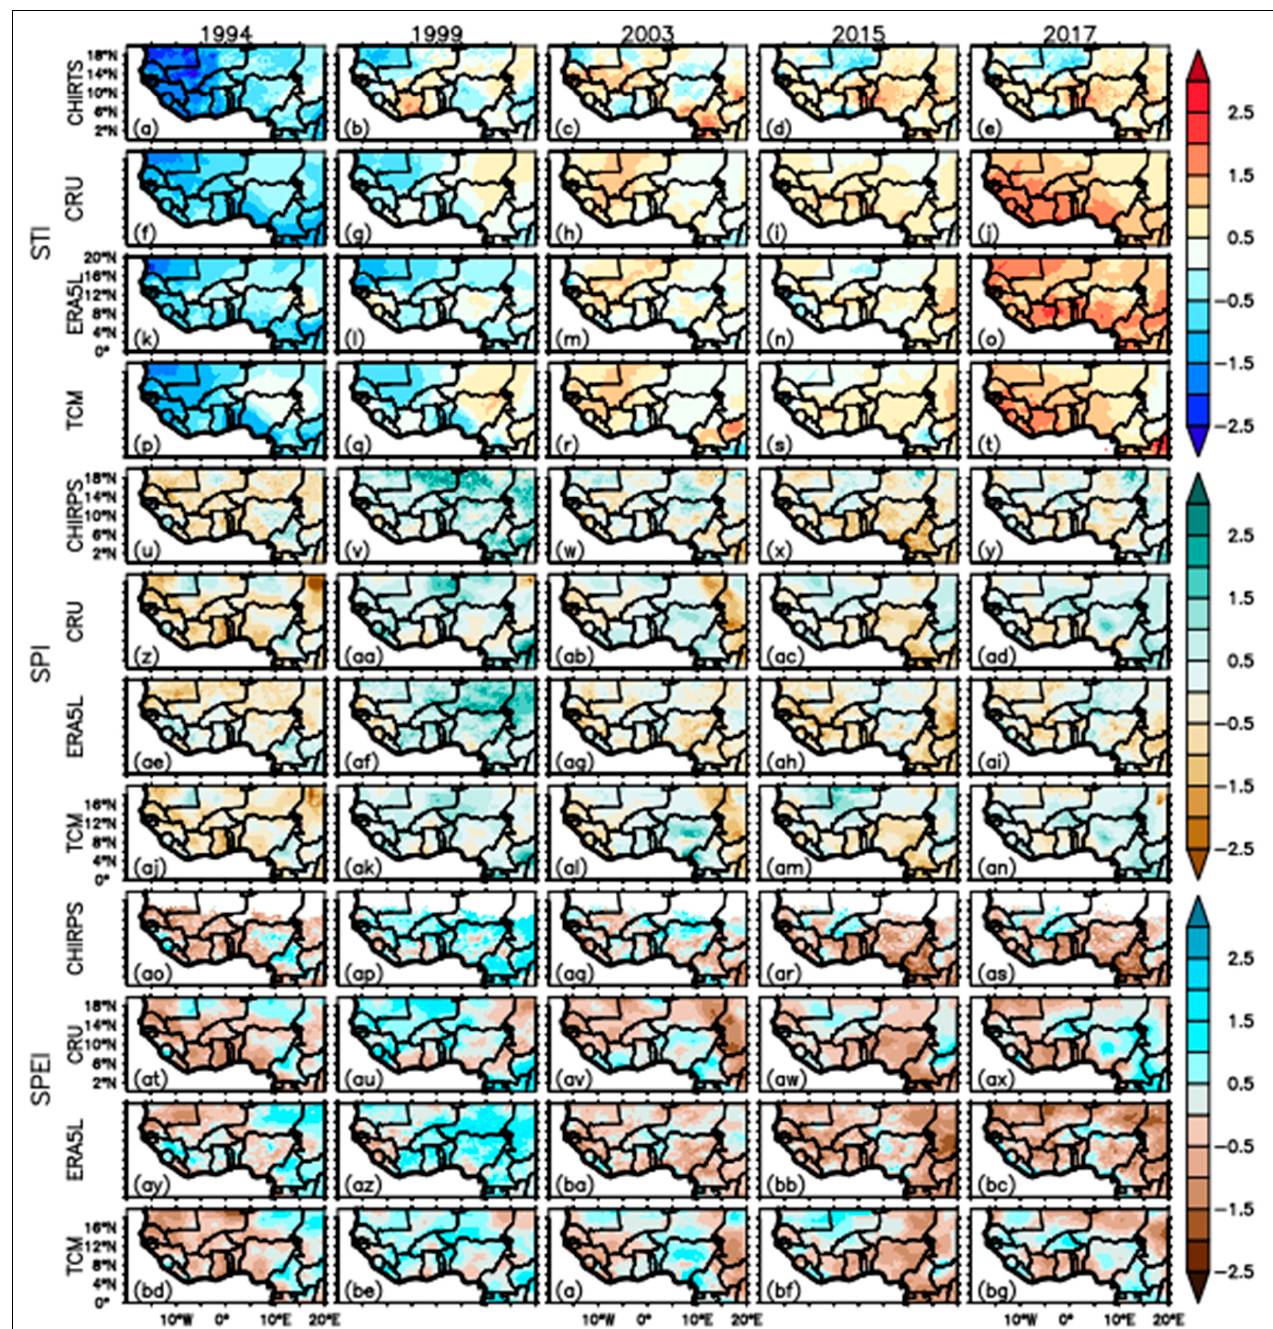
Figure A1. ( a – bg ) Climatic conditions before abrupt land cover changes.